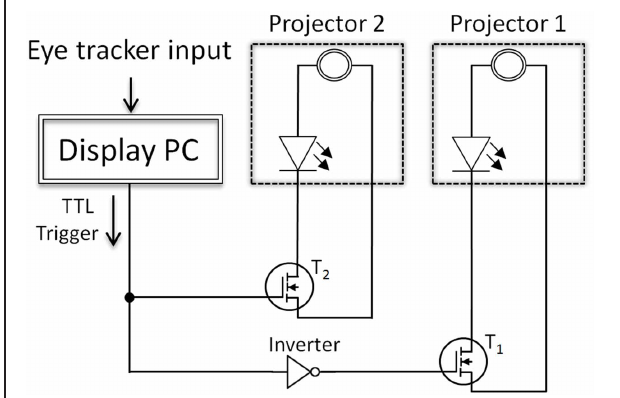
FIGURE 2 | Schematic depiction of the switching circuit. T 1 and T 2 mark the power transistors that were used to switch the projectors either on or off. After the eye tracker indicated that the eye crossed the invisible boundary, the display change was initiated by a TTL trigger. This trigger was read out by the electronic circuit, which either connected or disconnected the projectors’ LEDs from their original power sources. Note that this illustration is simplified and the actual circuit included six transistors—one for each LED of the two